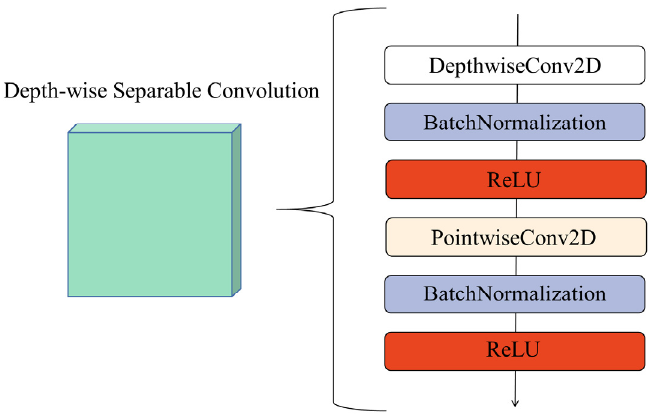
Figure 4. The structure of depth-wise separable convolution.